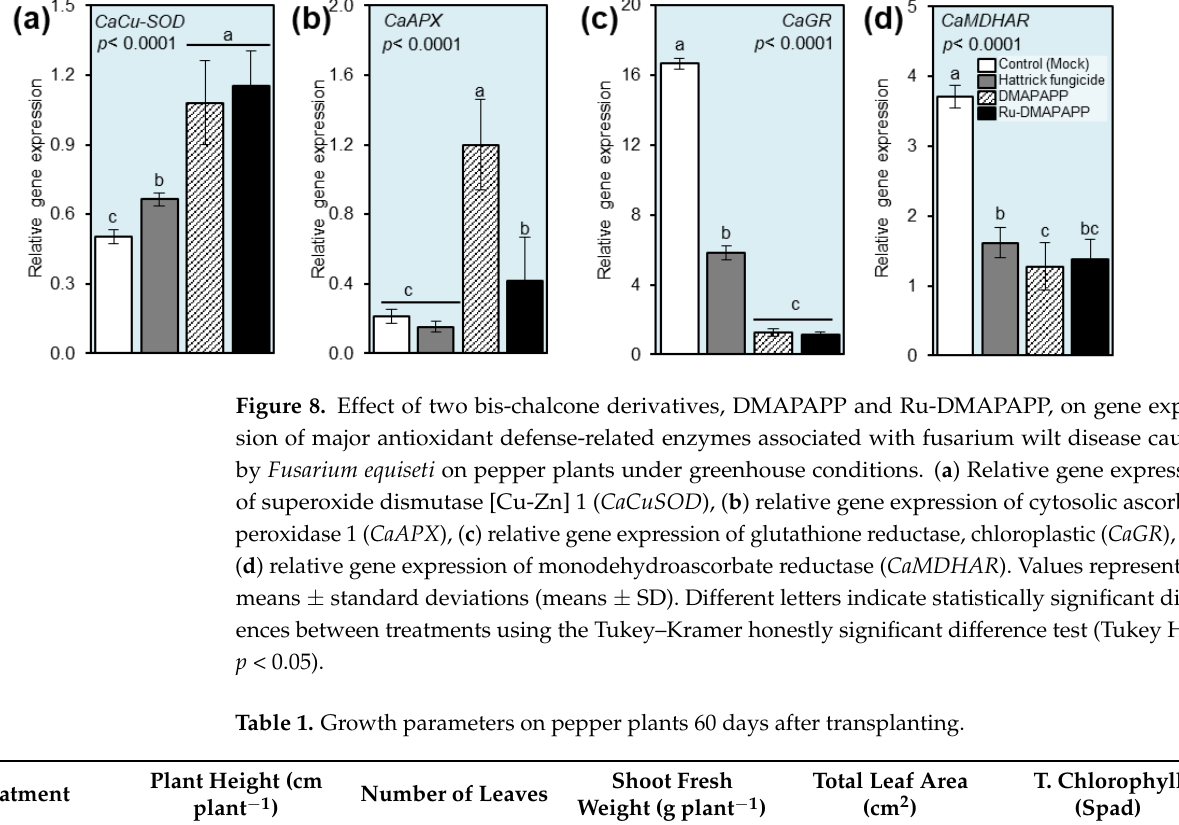
Figure 7. Effect of two bis-chalcone derivatives, DMAPAPP or Ru-DMAPAPP, on the enzymatic activity of the major antioxidant defense-related enzymes associated with fusarium wilt disease caused by Fusarium equiseti on pepper plants under greenhouse conditions. ( a ) Peroxidase activity (μM tetraguaiacol g −1 FW min −1 ), ( b ) polyphenol oxidase activity (arbitrary units), and ( c ) catalase activity (μM H 2 O 2 g −1 FW min −1 ). Values represent the means ± standard deviations (means ± SD). Different letters indicate statistically significant differences between treatments using the Tukey – Kramer honestly significant difference test (Tukey HSD; p < 0.05).